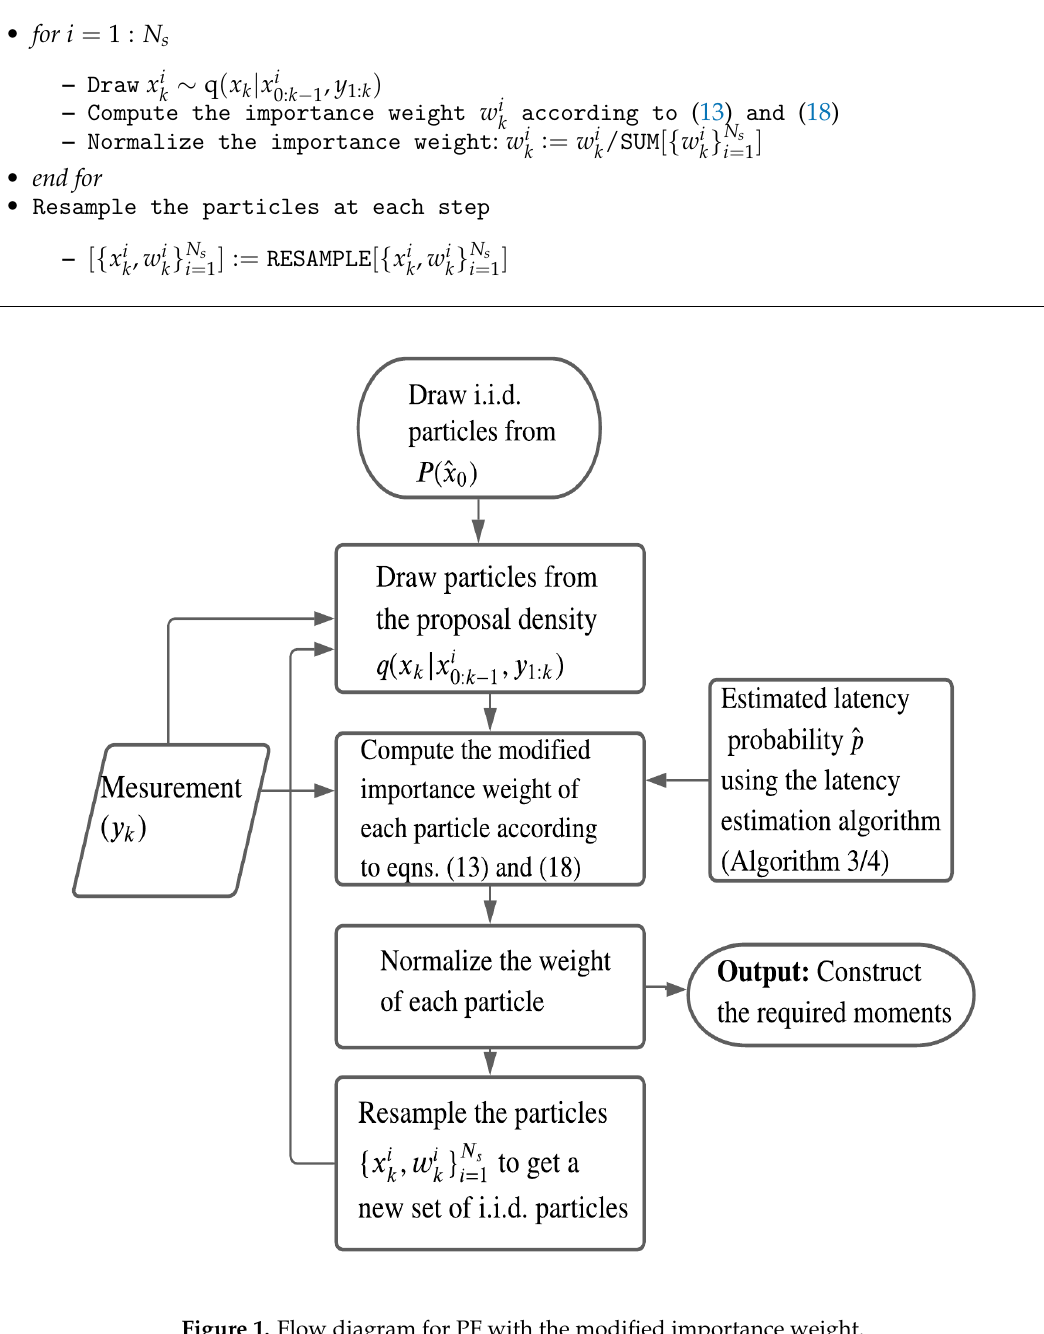
Figure 1. Flow diagram for PF with the modified importance